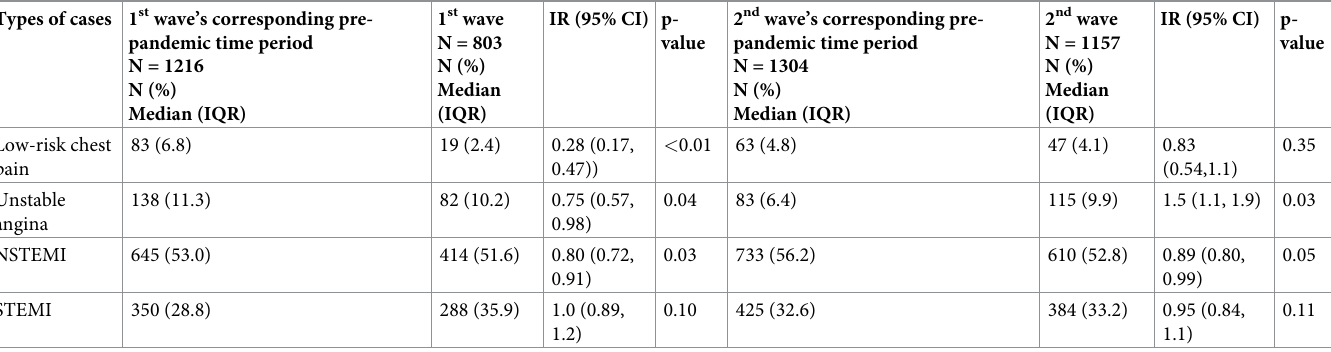
Table 2. Types of ACS patients admitted during 1 st and 2 nd COVID waves and matched pre-pandemic months. Types of cases 1 st wave’s corresponding pre- pandemic time period